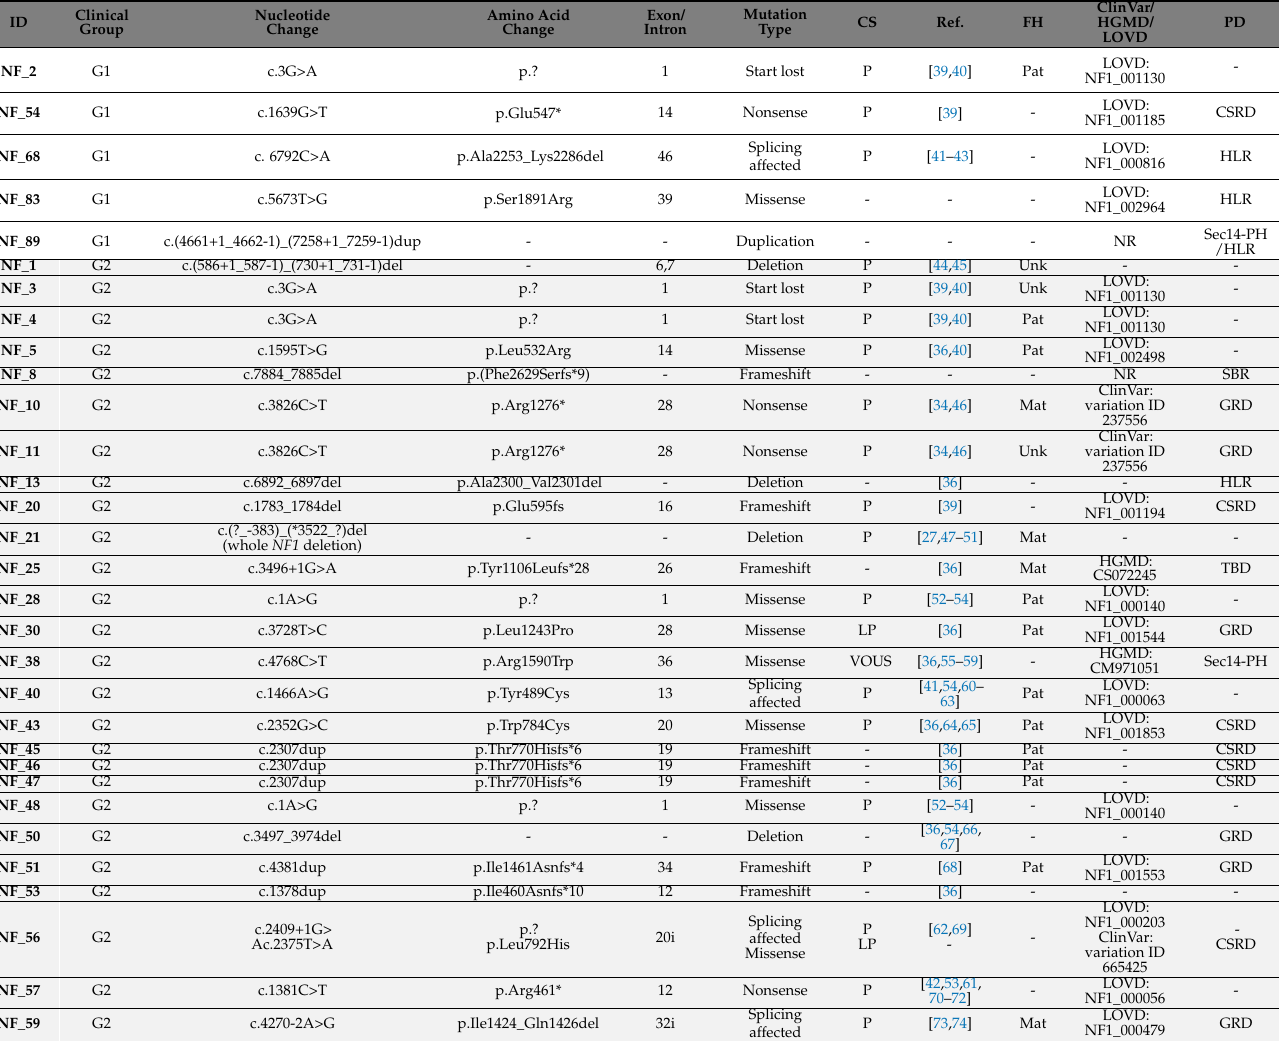
Table 1. Molecular characteristics of the NF1 cohort, according to clinical groups